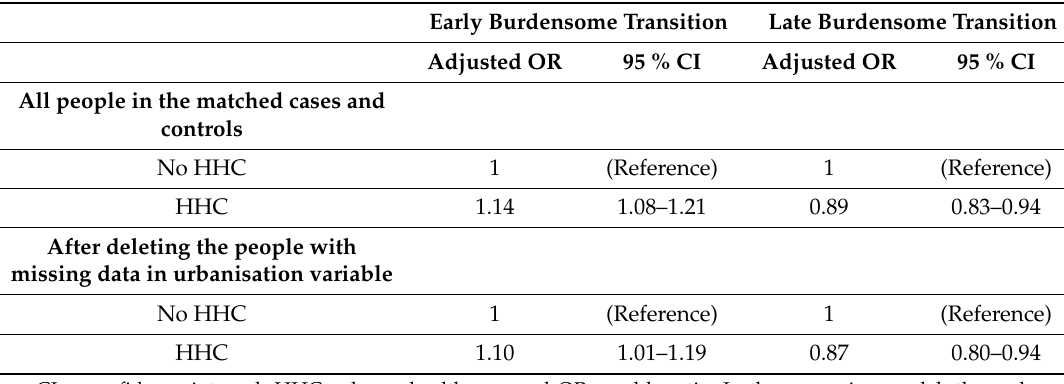
Table A4. Sensitivity test for the influence by the missing data in the urbanisation variable on the risk of burdensome transition at the end-of-lie in people with dementia who received home healthcare compared with those who had no home healthcare services.